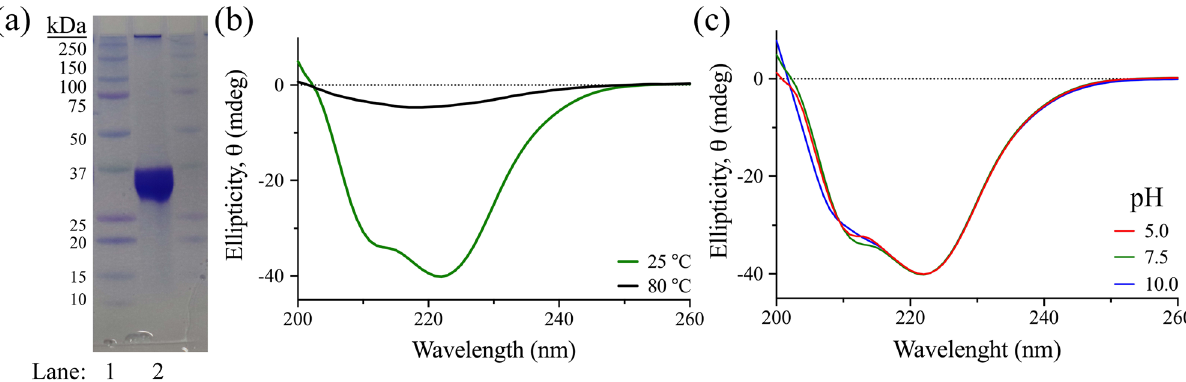
Figure 2. The SDS-PAGE analysis and far-UV CD scans of 3CLpro. ( a ) SDS-PAGE analysis of the 3CLpro with Coomassie-stain for visualization of the protein bands. The molecular weight marker and 3CLpro sample are loaded to lanes 1 and 2, respectively. ( b ) Far UV-CD spectra (280–200 nm) of 3CLpro at pH 7.5 for native (green) and denature (black) states collected at 25 °C and after 30 min incubation at 80 °C, respectively. Each spectrum is an average of five CD scans. ( c ) Far UV-CD spectra of native-state of 3CLpro collected at 25 °C in different pH values of 5.0 (red), 7.5 (green), and 10.0